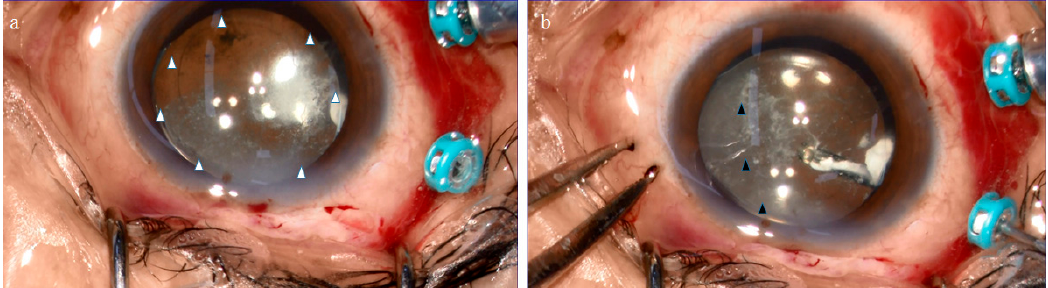
Figure 2. Surgical procedure used to obtain the Berger’s space (BS) specimens. TA was injected into the BS from behind during vitrectomy in order to visualize the configuration ( a ). The periphery of the BS was firmly adhered to the lens with a circular ligamentous structure, known as Wieger’s ligament ( a ; white arrowheads). A septum-like structure appeared to divide the BS into a two-thirds temporal and one-third nasal formation ( b ; black arrowheads). The BS specimen was then separated from the lens via aspiration of its posterior wall with a vitreous cutter. The specimen was then released into the vitreous cavity and selectively collected with the vitreous